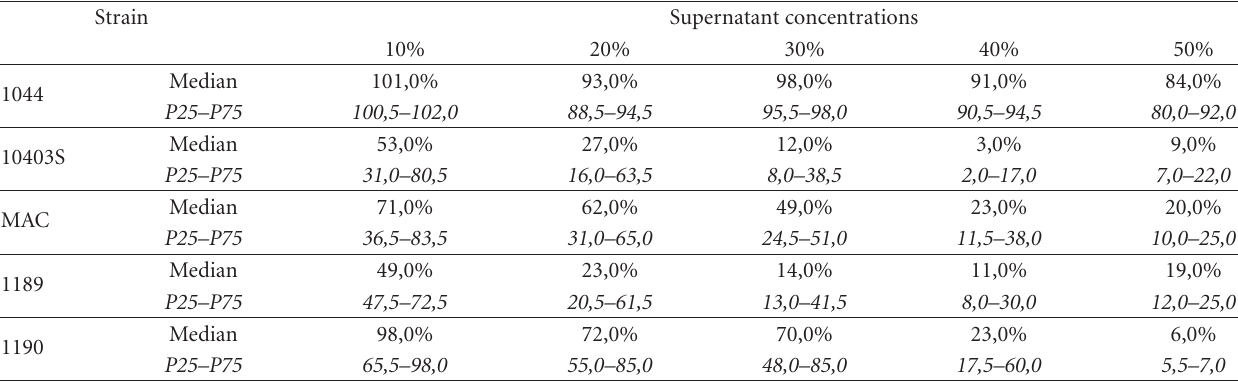
Table 4: Survival of PBMC cells of B-CLL patient treated with di ff erent concentrations of L. monocytogenes strain supernatants. Strain